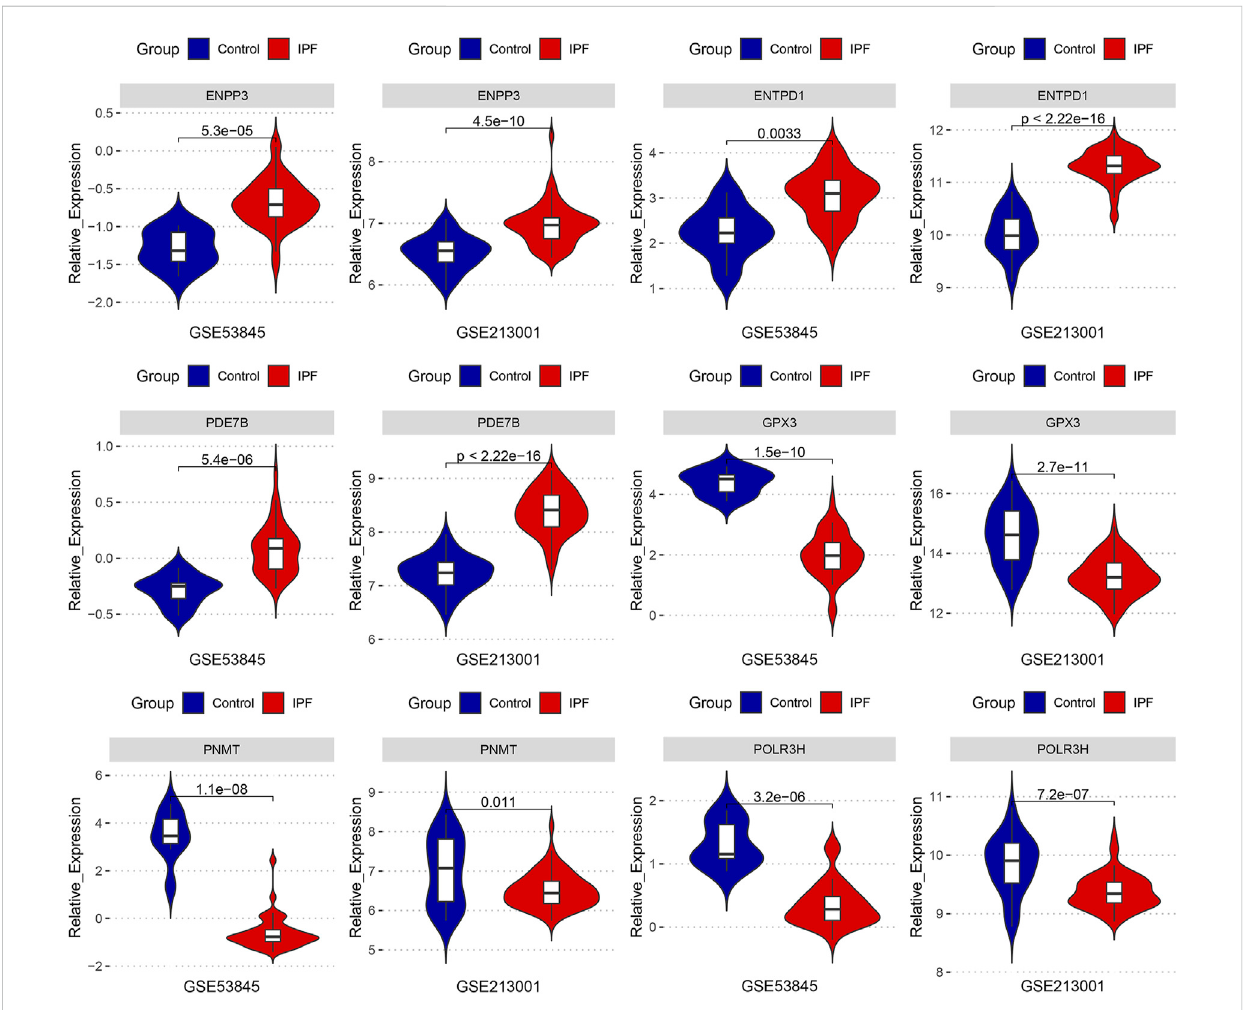
FIGURE 7 The expression levels of six key DEMRGs were validated in two independent external datasets (GSE53845 and GSE213001): ENPP3, ENTPD1, and PDE7B were signi fi cantly upregulated in IPF lung tissue ( p < 0.05), while GPX3, PNMT, and POLR3H were signi fi cantly downregulated in IPF lung tissue ( p <